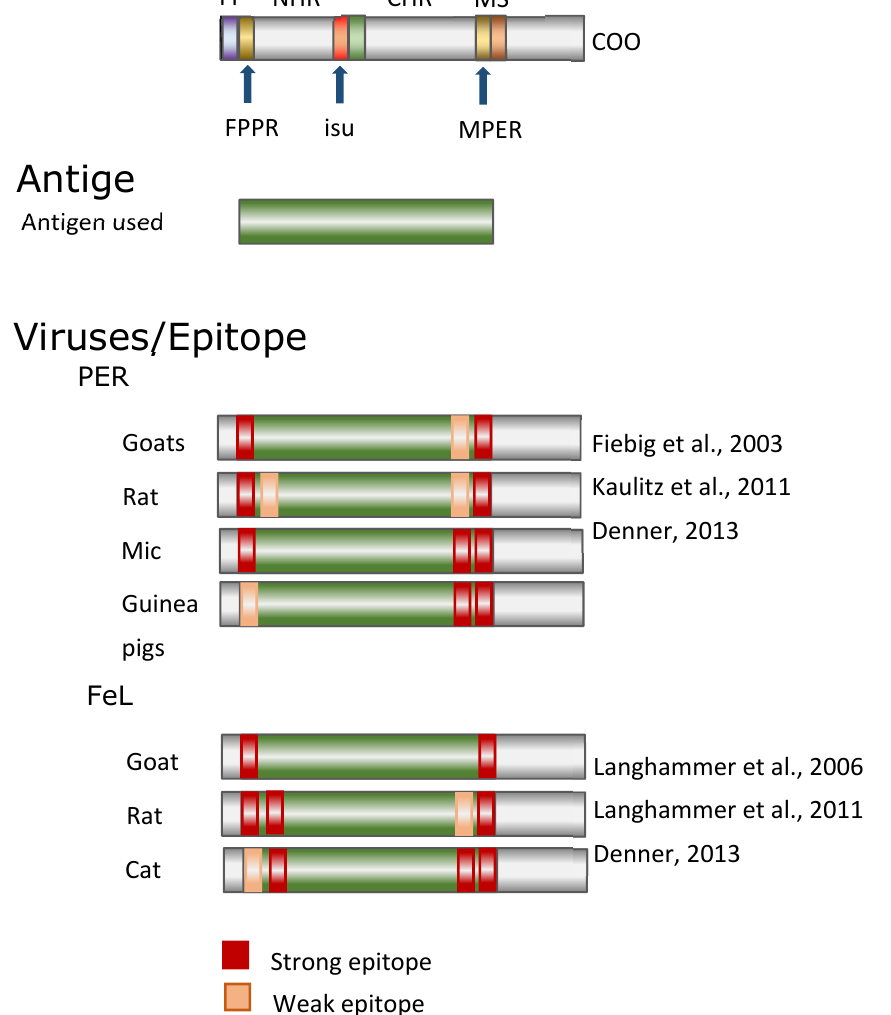
Figure 3. ( A ), Schematic presentation of the TM envelope proteins. The relevant domains are indicated (see Figure 1). ( B ), Antigen used for immunization: ectodomains of the related retroviruses PERV and FeLV, ( C ), localization of the epitopes recognized by antisera obtained after immunization with the ectodomains of TM envelope proteins of PERV and FeLV. The animals and the publications are indicated ([38 − 40], [42 − 44]).